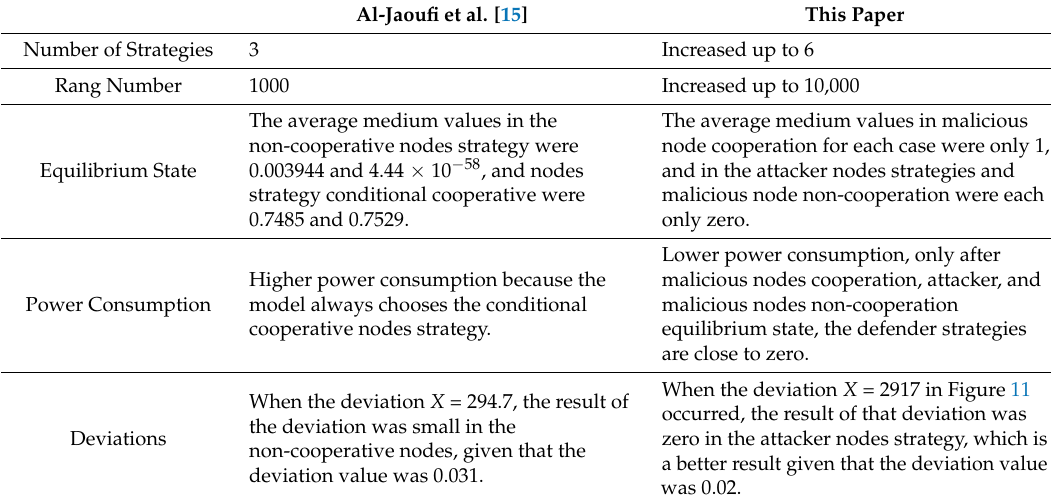
Table 7. Compared with Al-Jaoufi et al.